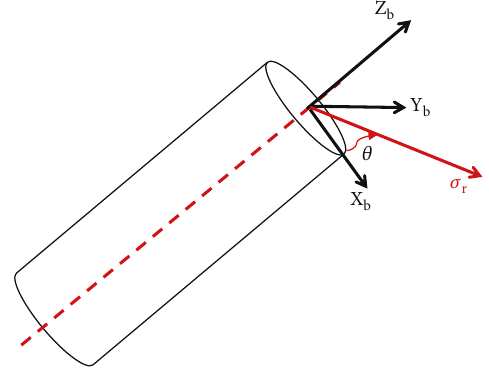
Figure 6: Reference coordinate systems of BPCS and